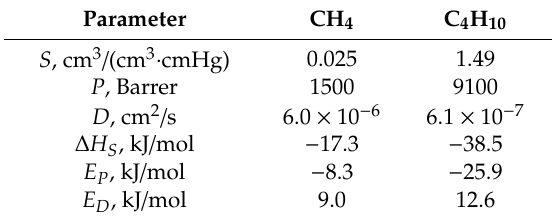
Table 5. Membrane parameters for methane and butane in PMPentyne at 25 ◦ C